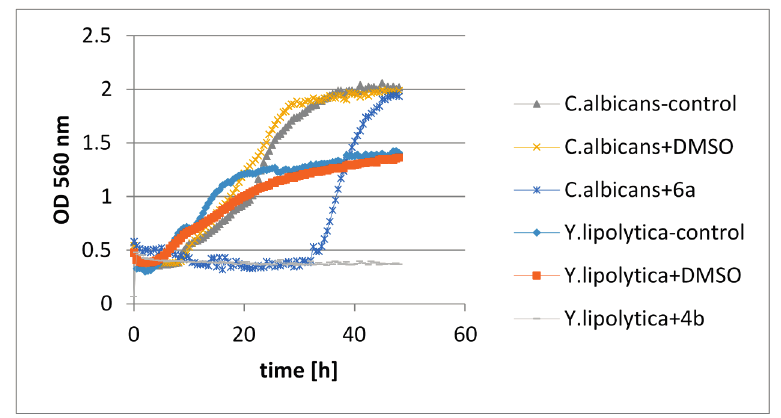
Figure 6. Examples of the effects of selected lactones on the chosen yeast